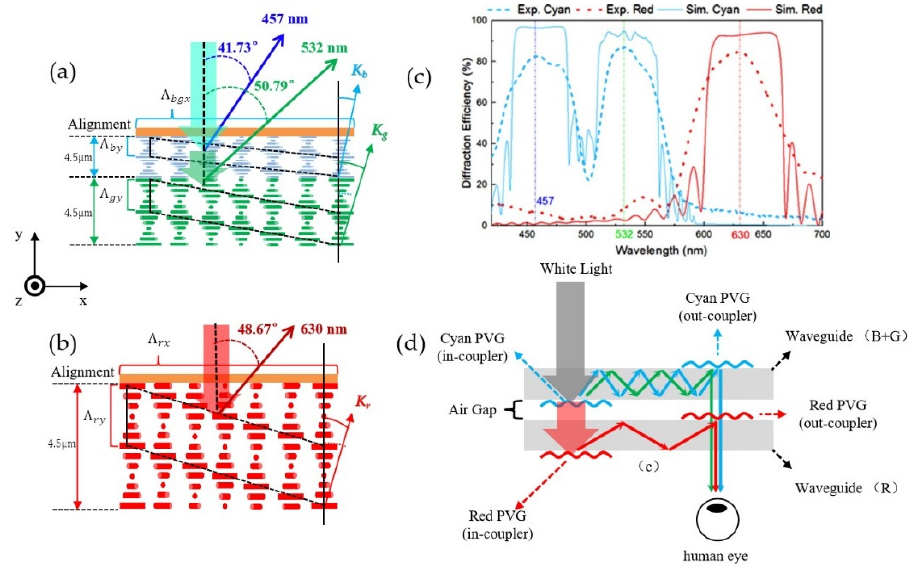
Figure 10. Schematic drawing for (a) the dual-layer polarized volume gratings (PVGs) used as an in-coupled grating of the planar waveguides in a 2D/3D wearable display device (b) .